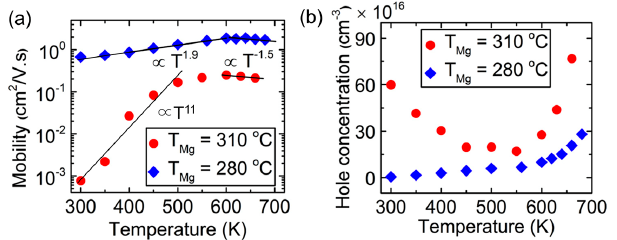
Figure 9. ( a , b ) Hole mobility and concentration vs. temperature for Mg-doped AlN nanowires with different doping concentrations. The lines are linear fits [87].